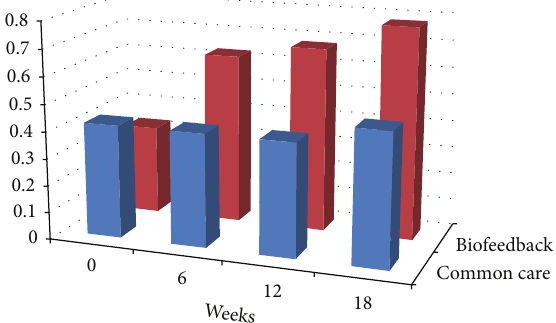
Figure 1: The graph shows BCVA of group A who performed rehabilitation with MP-1 biofeedback (BF) and BCVA of group B which was used as a control group at baseline and after 6 weeks, 12 weeks, and 18